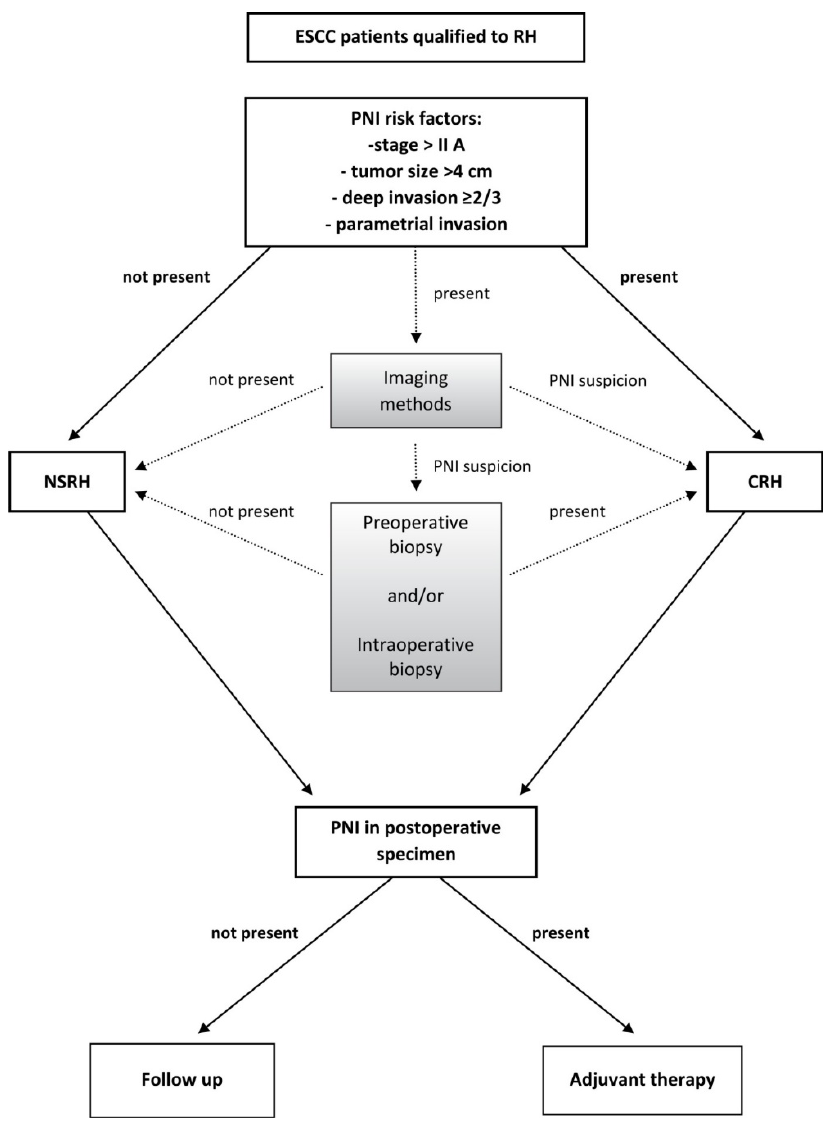
Figure 3. The PNI diagnostic algorithm in ESCC patients qualified to surgical treatment with RH. The shadow areas are suggested methods applicable in future.